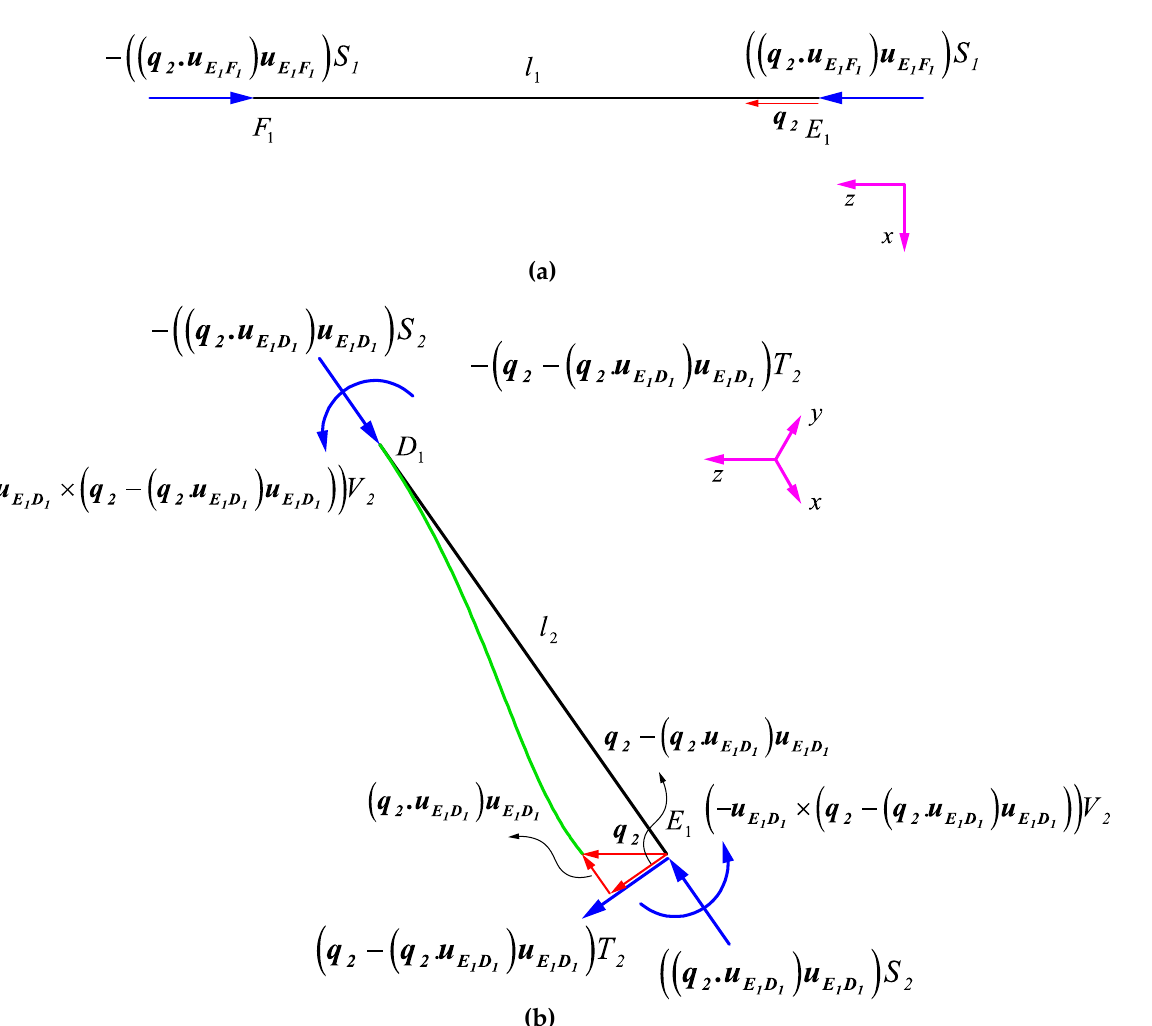
Figure 7. Deformation and loads applied on struts ( a ) EF and ( b ) ED due to q 2 = 1.